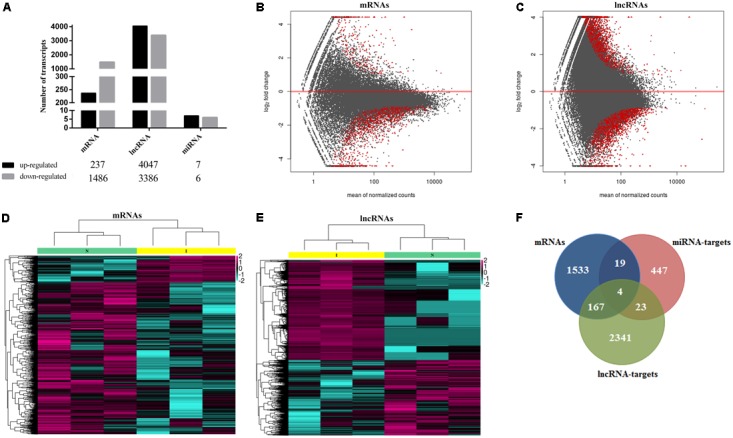
Transcriptional landscape of mRNAs, lncRNAs, and miRNAs in ALV-J infected chicken. (A) Number of differentially expressed mRNAs, lncRNAs and miRNAs in chicken spleens of ALV-J infected group vs. uninfected group detected by high-throughput sequence (P-value < 0.05 and fold-change ≥2). MA graph of mRNAs (B) and lncRNAs (C) expression levels between ALV-J infected and uninfected group. The red dots represented differentially expressed mRNAs, >0 represented upregulated and <0 represented downregulated (P-value < 0.05 and fold-change ≥2). Heatmaps of 1,723 significantly differentially expressed mRNAs (D) and 7,883 significantly differentially expressed lncRNAs (E) show normalized expression values. Columns represent samples, and rows represent transcripts. Colors are used to represent expression levels: above (aubergine) or below (cyan) (expression data was normalized from -2 to +2). I, ALV-J infected tissues; N, normal uninfected tissues. (F) Venn diagrams of differentially expressed mRNAs, miRNA targets, and lncRNA targets.